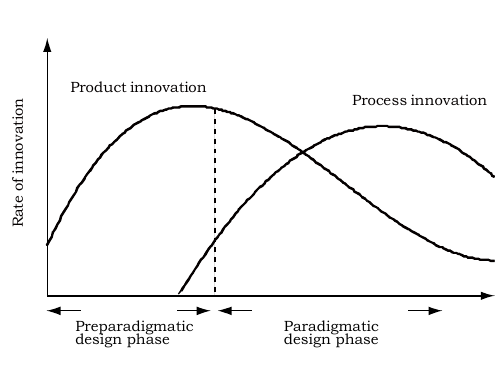
Figure 5. A-U model in Teece (1986) From “Profiting from technological innovation,” by D. Teece, 1986, Research Policy , 15 (6), p. 289, Figure 4. Copyright 1986. Reprinted by permission of Elsevier.